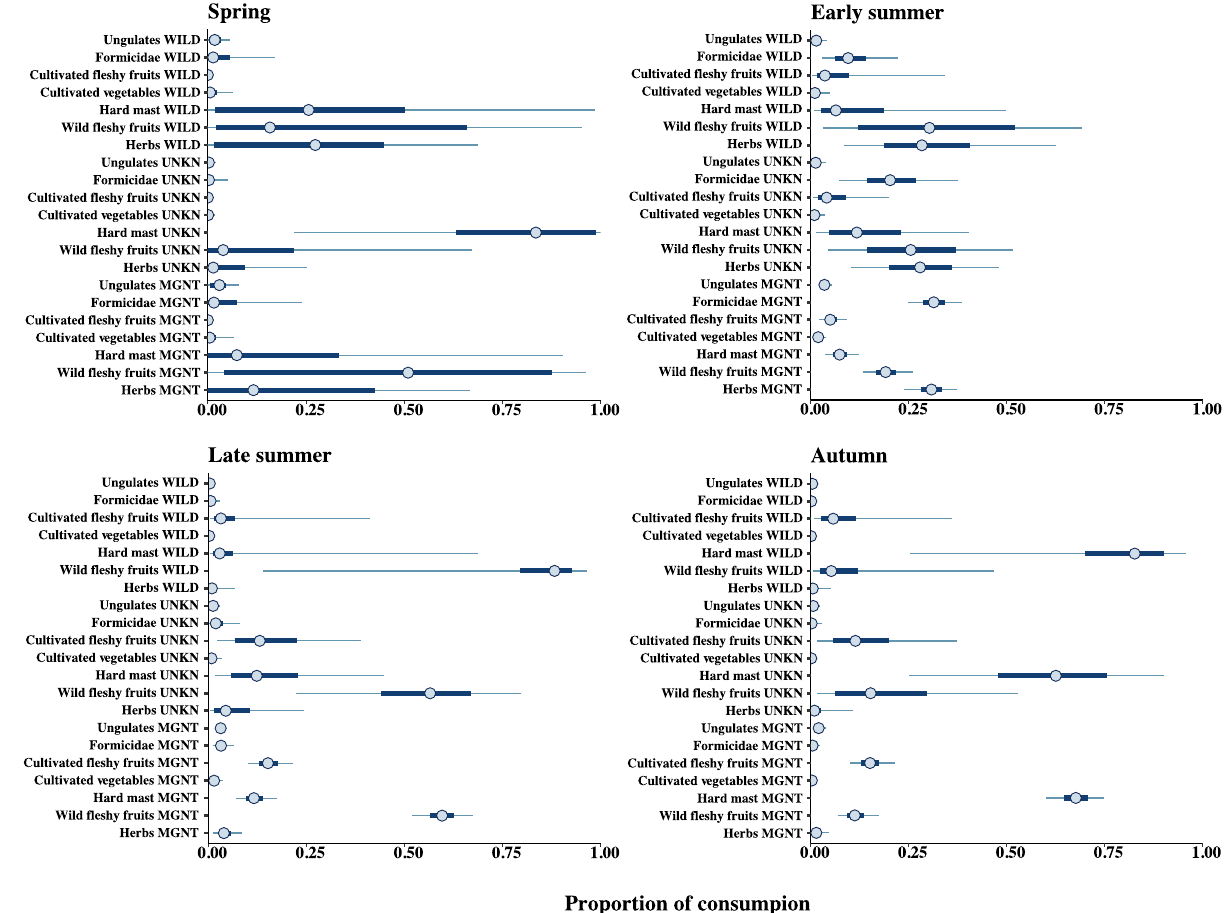
Figure 5. Mean estimated posterior proportional dietary contribution for wild (WILD), unknown (UNKN) and management (MGNT) Apennine Brown bears in four dietary seasons (Abruzzo Lazio and Molise National Park, central Italy, June–September 2014). Circles represent the median contribution, of each key-food category, to bears diet, with 95% (thin lines) and 50% (thick lines) credibility